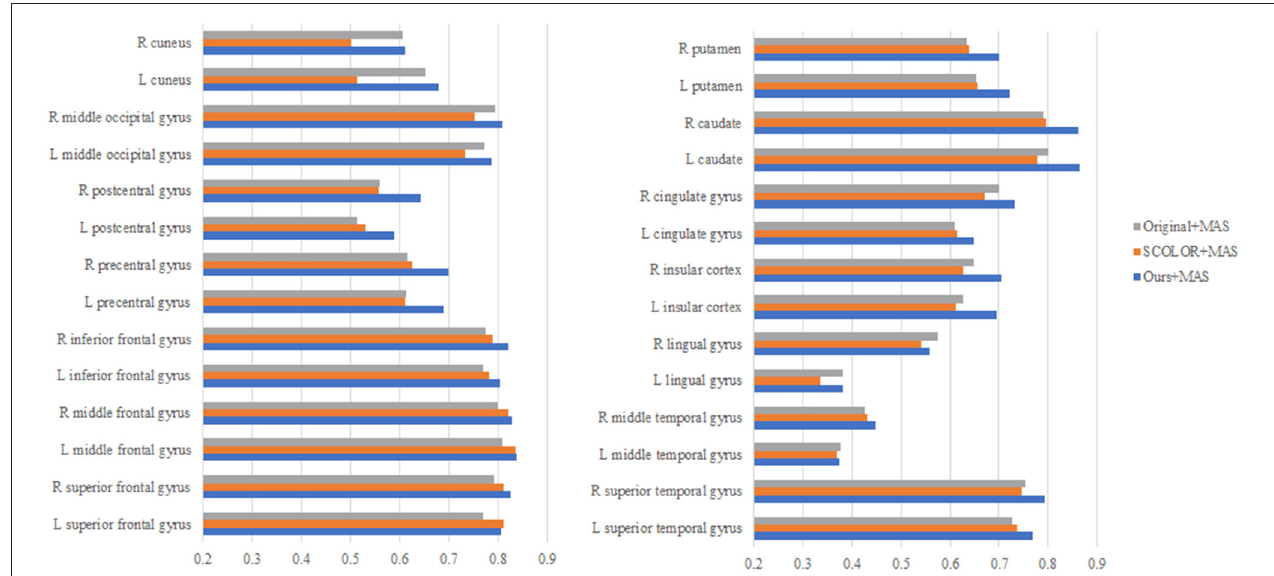
FIGURE 9 | The average Dice indices of different brain regions of 40 segmented brain tumor images using MAS and MAS our recovered images, +